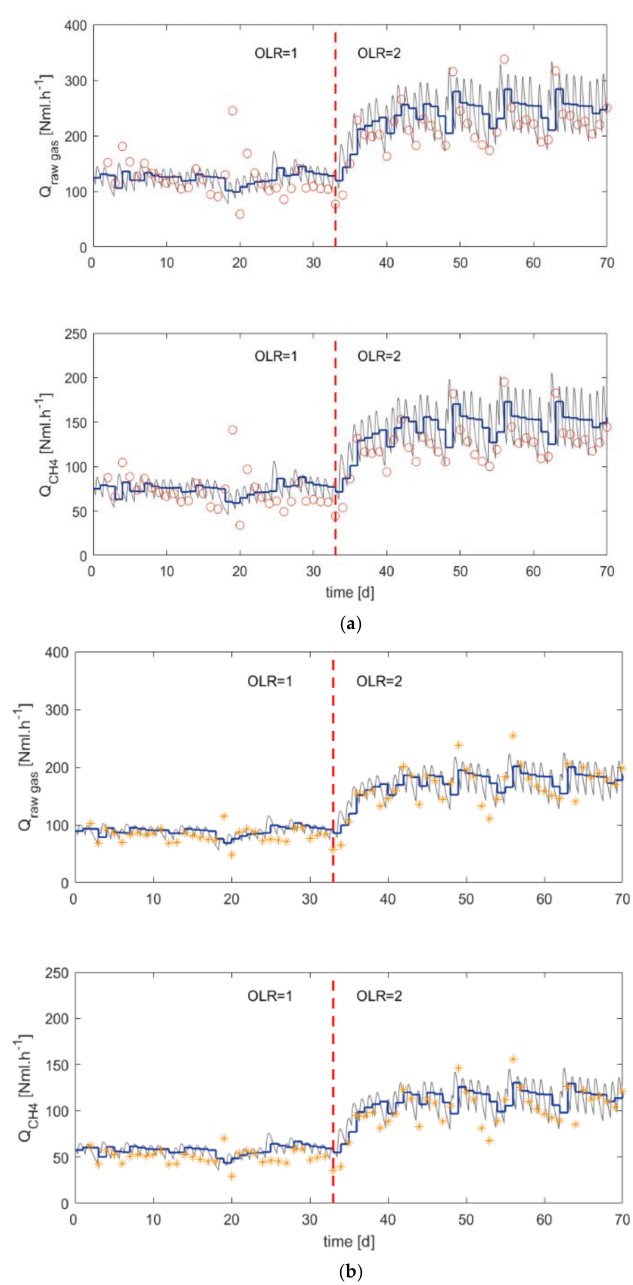
Figure 3. ( a ) Gas production for the continuous lab-scale reactor R1; ( b ) Gas production for the reference reactor R2. Total gas flow (top) and methane flow (bottom). Markers represent the data for daily gas production, grey lines represent the modelled instantaneous gas production, and blue lines show the modelled average daily gas production. The red dashed lines mark the time for load